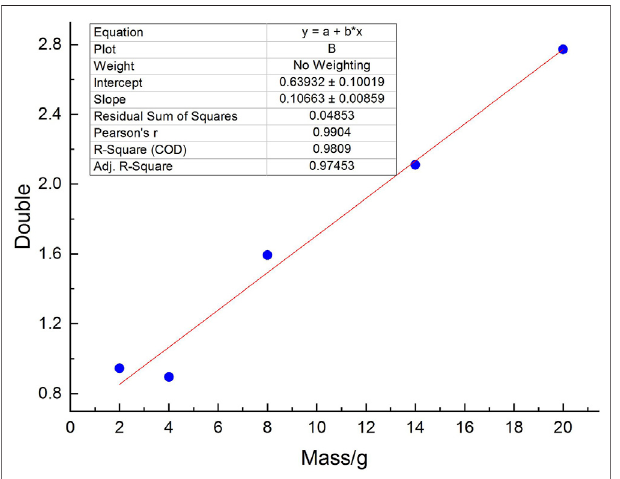
FIGURE 8 | Detection ef fi ciency of different packaging materials.